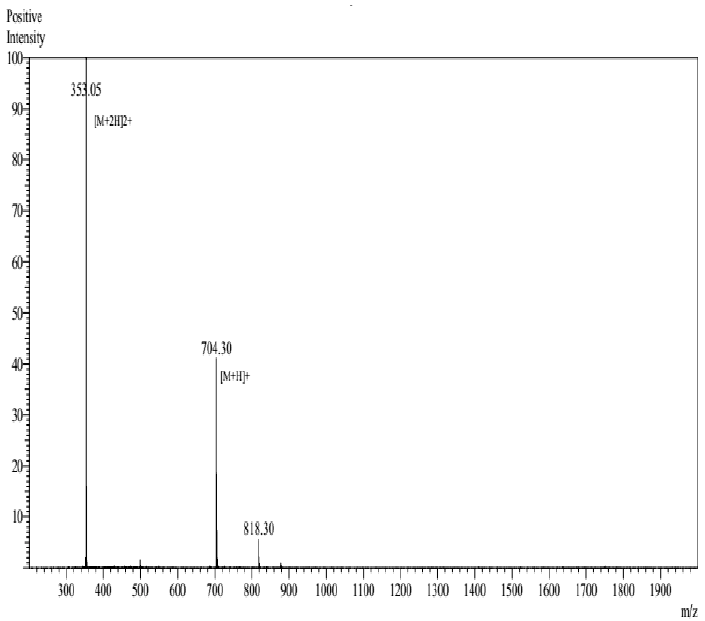
Figure A1. MS image of LA ‐ RWR.